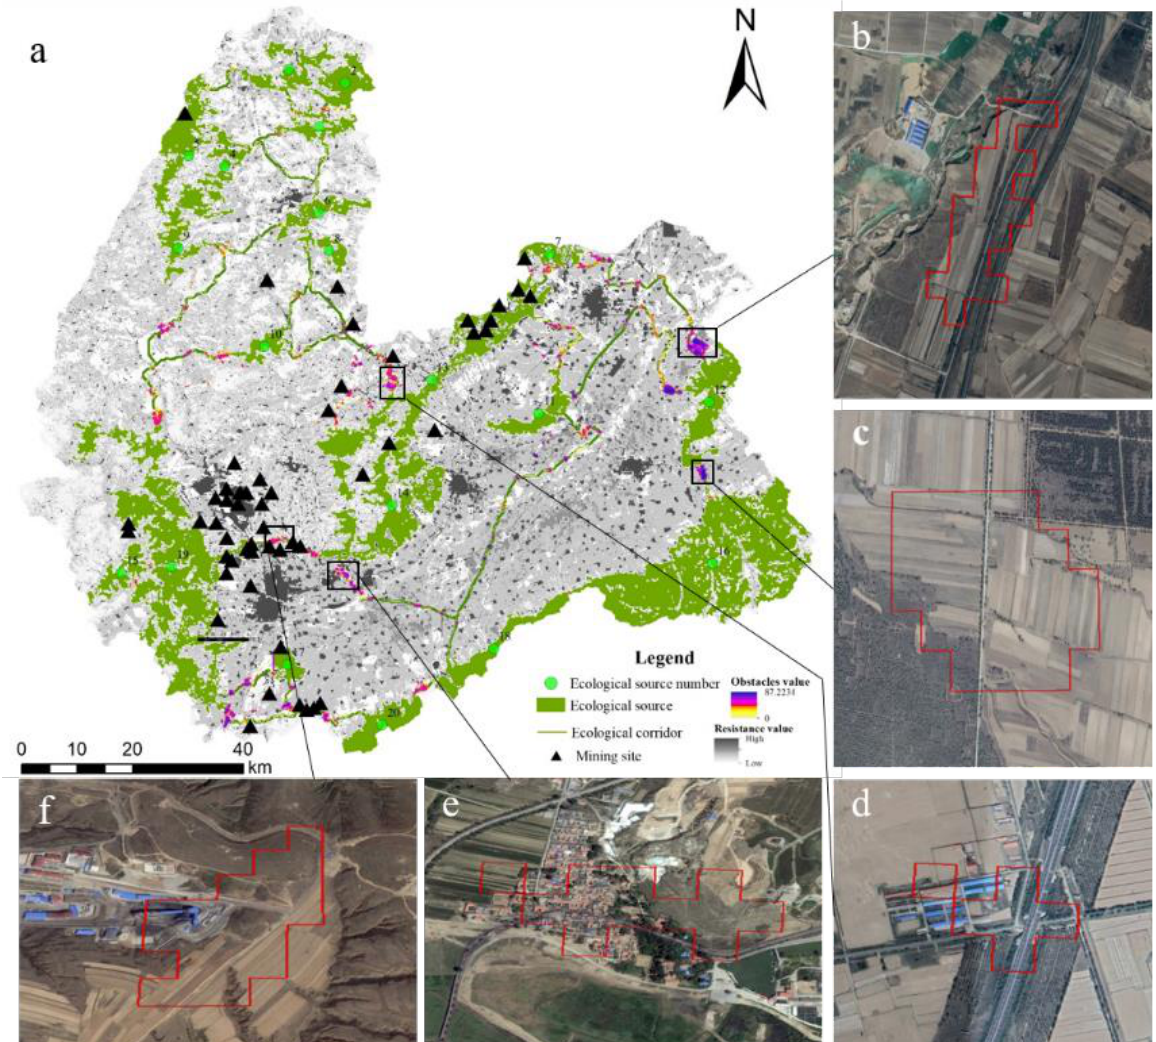
Figure 8. a ) Partial details of corridors and obstacles. Subfigures b – f are subfigures showing a real Figure 8. ( a ) Partial details of corridors and obstacles. Subfigures ( b – f ) are subfigures showing a real view of the view of the obstacles.